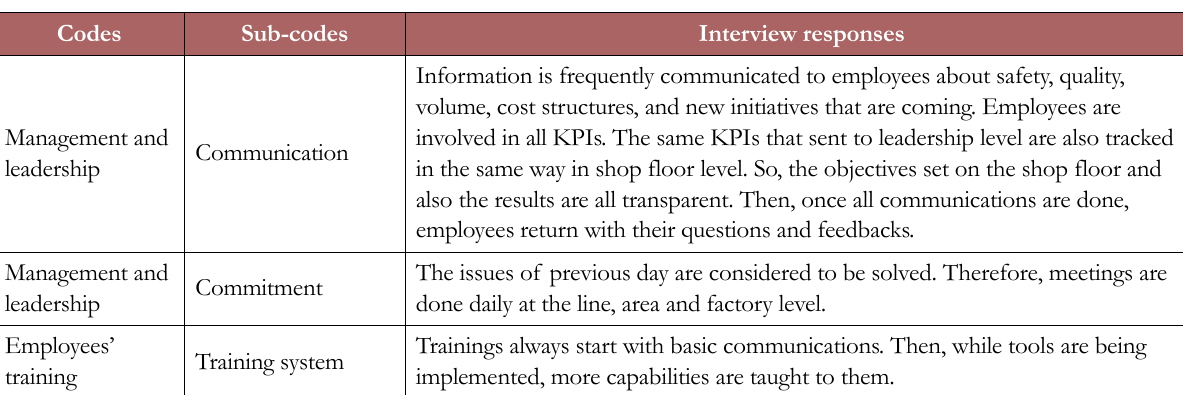
Table 4. Quotes of interviews related to dimension 4